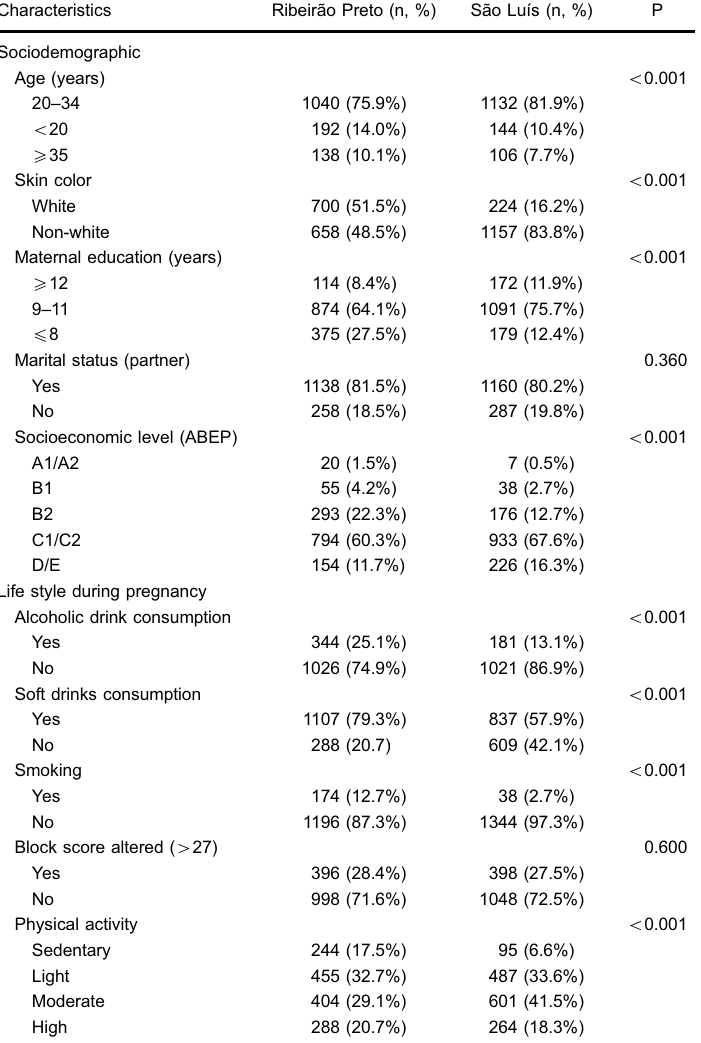
Table 1. Maternal sociodemographic characteristics and life styles during pregnancy. Comparison between the Ribeirão Preto and São Luís 2010